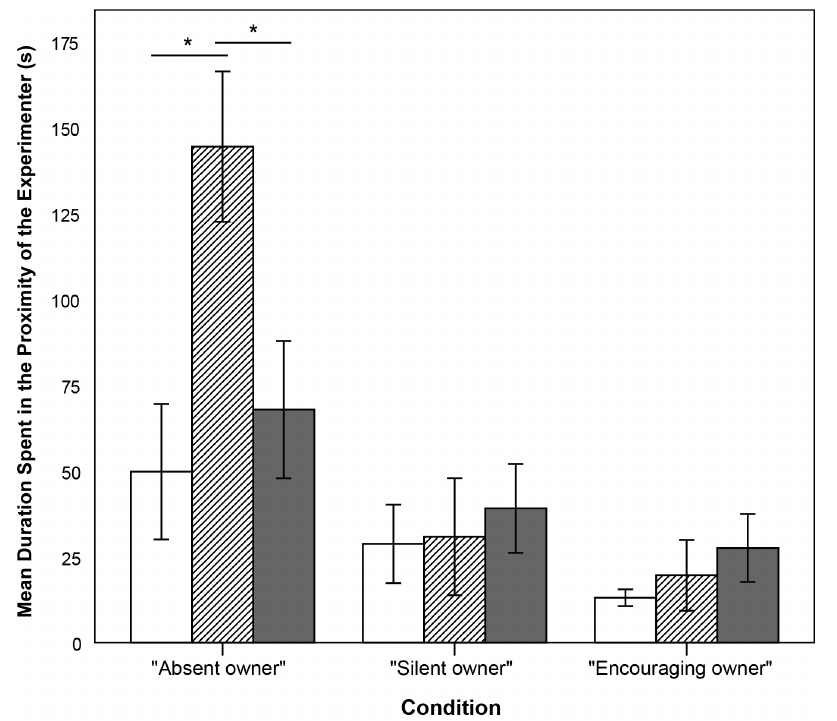
Figure 4. Duration spent in the proximity of the experimenter – Experiment 1. Mean duration spent in the proximity of the experimenter in the conditions ‘‘Absent owner’’ (cAO), ‘‘Silent owner’’ (cSO), and ‘‘Encouraging owner’’ (cEO). White bars represent the 1 st trials, striped bars represent the 2 nd trials, grey bars represent the 3 rd trials. Shown are mean 6 s.e.m. * represents P # 0.05.